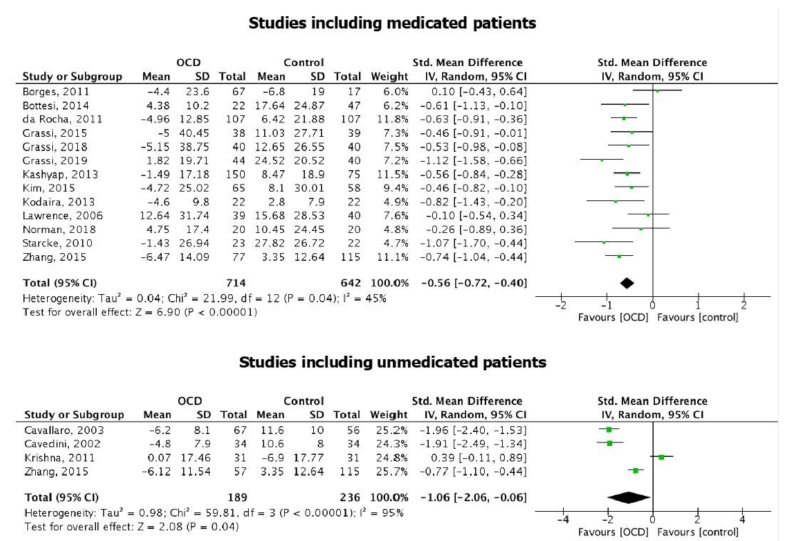
Figure 6. Forest plot of the studies including medicated patients and the studies including unmedi- cated